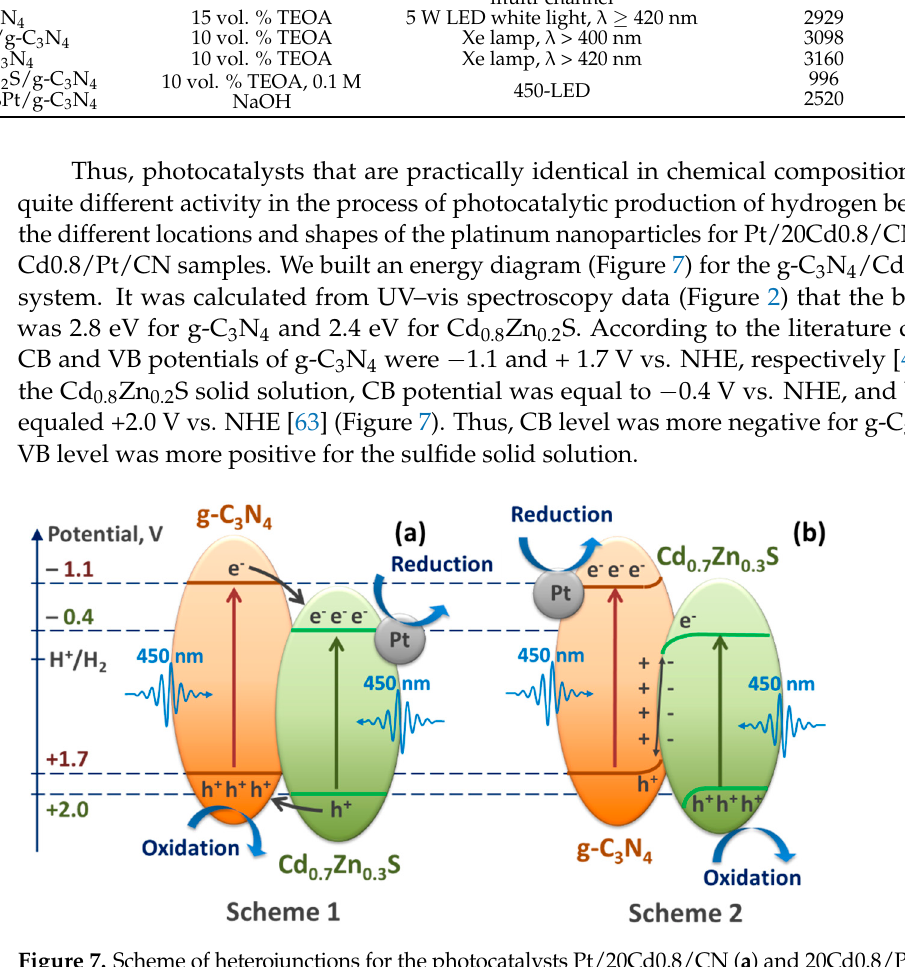
Table 4. Comparison of the results with previously published data.